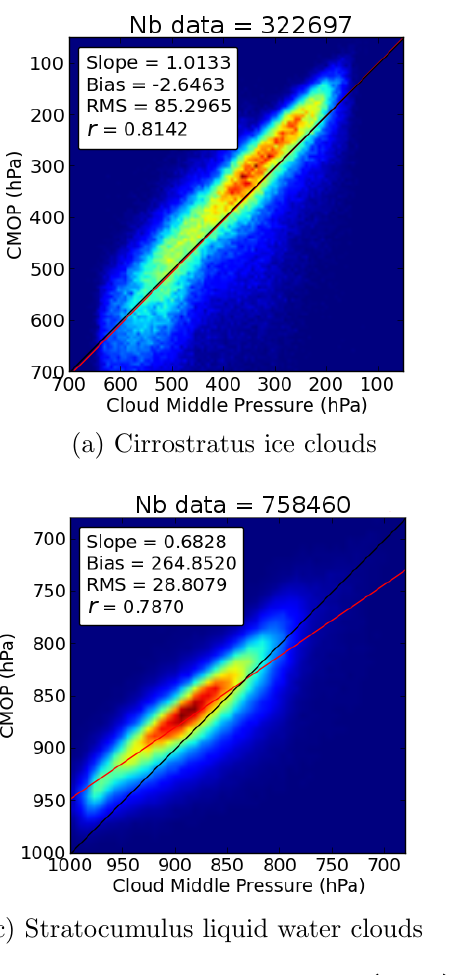
Fig. 6. Evaluation of POLDER cloud middle oxygen pressure (CMOP) versus CPR/CALIOP cloud middle pressure (in abscissa). Cases over ocean in 2008. Black lines indicate the one-to-one relationship, while red lines indicate the linear regression between CMOP and